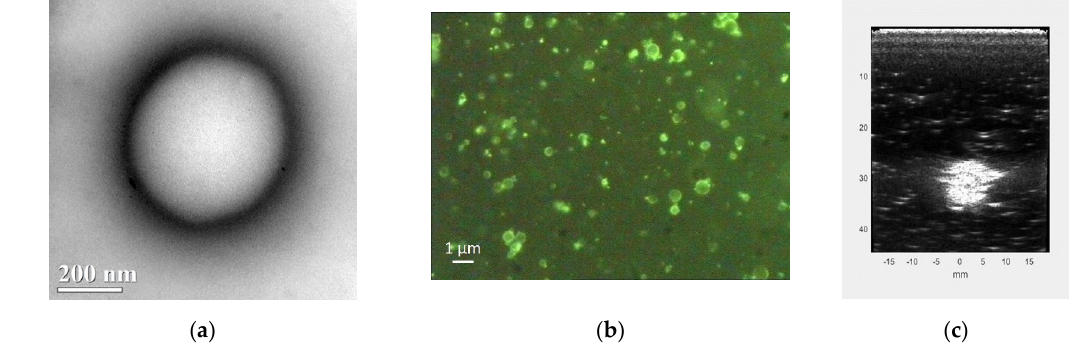
Figure 1. Structure of the oxygen-loaded nanosystem.